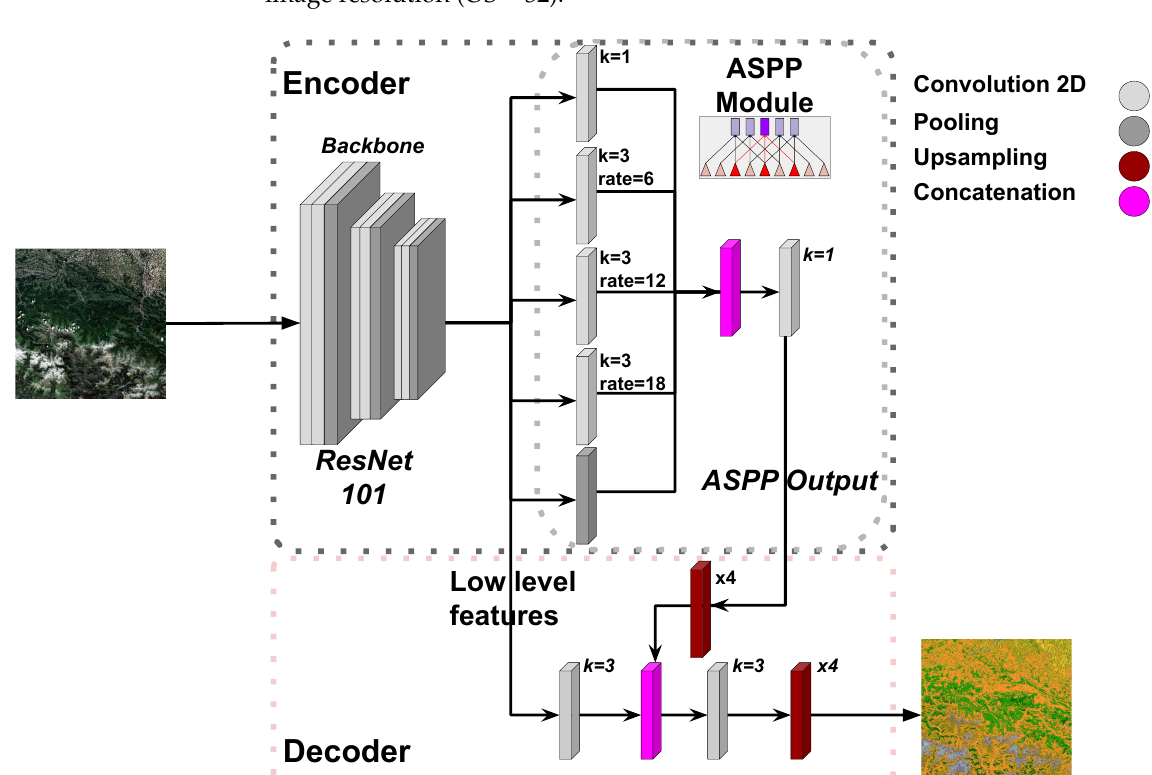
Figure 4. DeepLabV3+ architecture with Atrous Spatial Pyramid Pooling (ASPP)